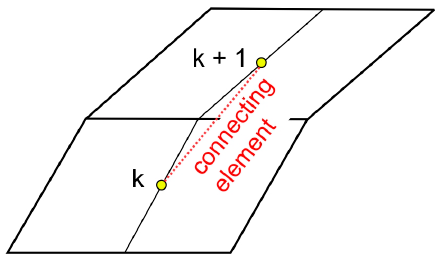
Figure 8. The free body diagram of element